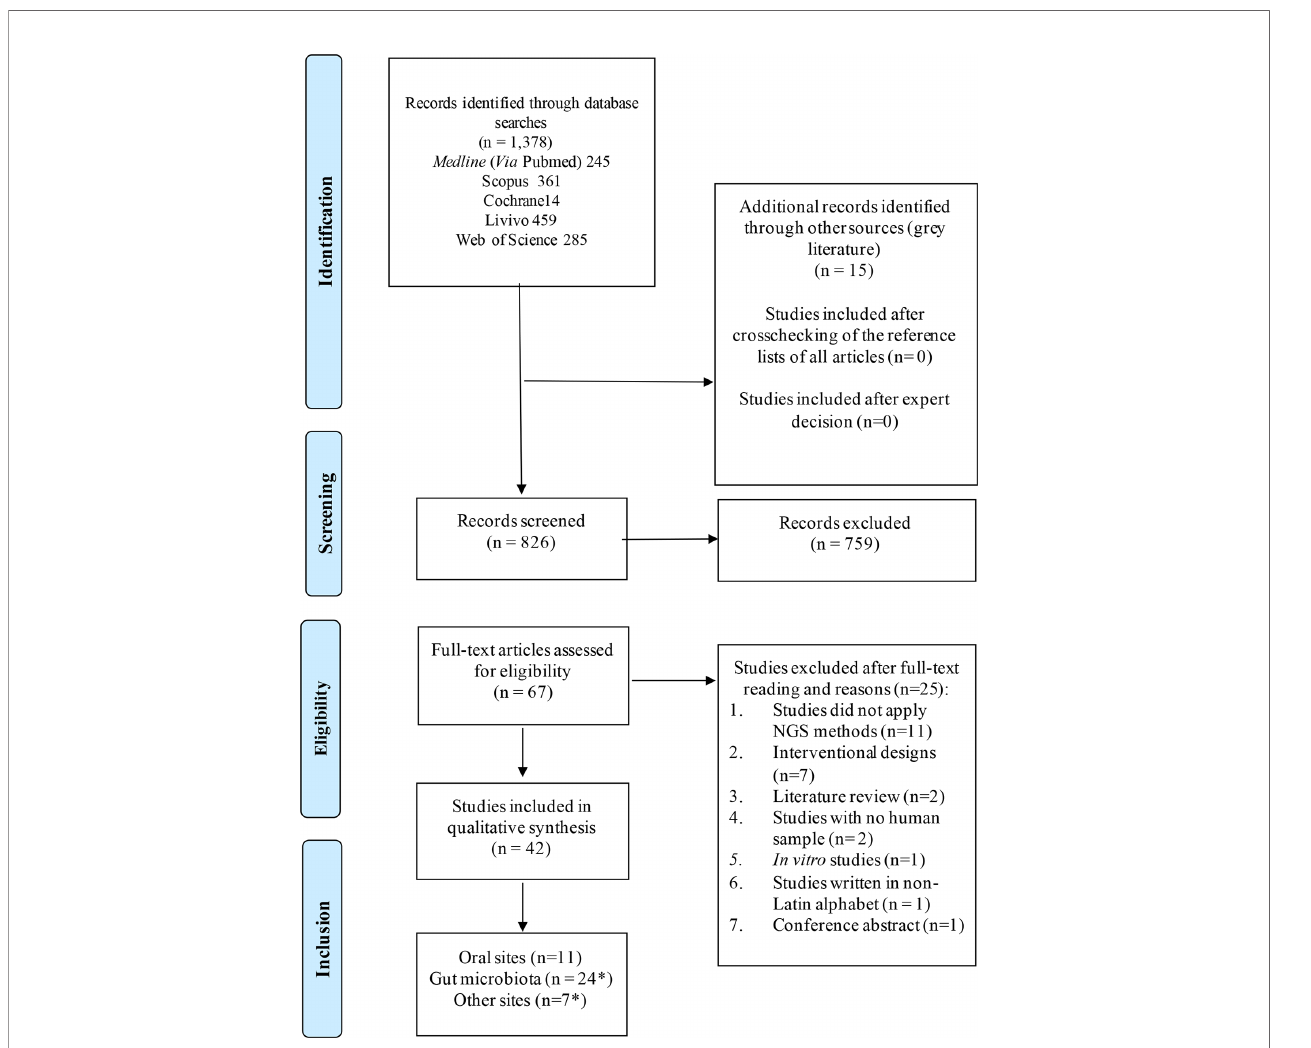
FIGURE 1 | Flow diagram for study selection according to PRISMA guidelines. *Some studies sampled multiple sites in one